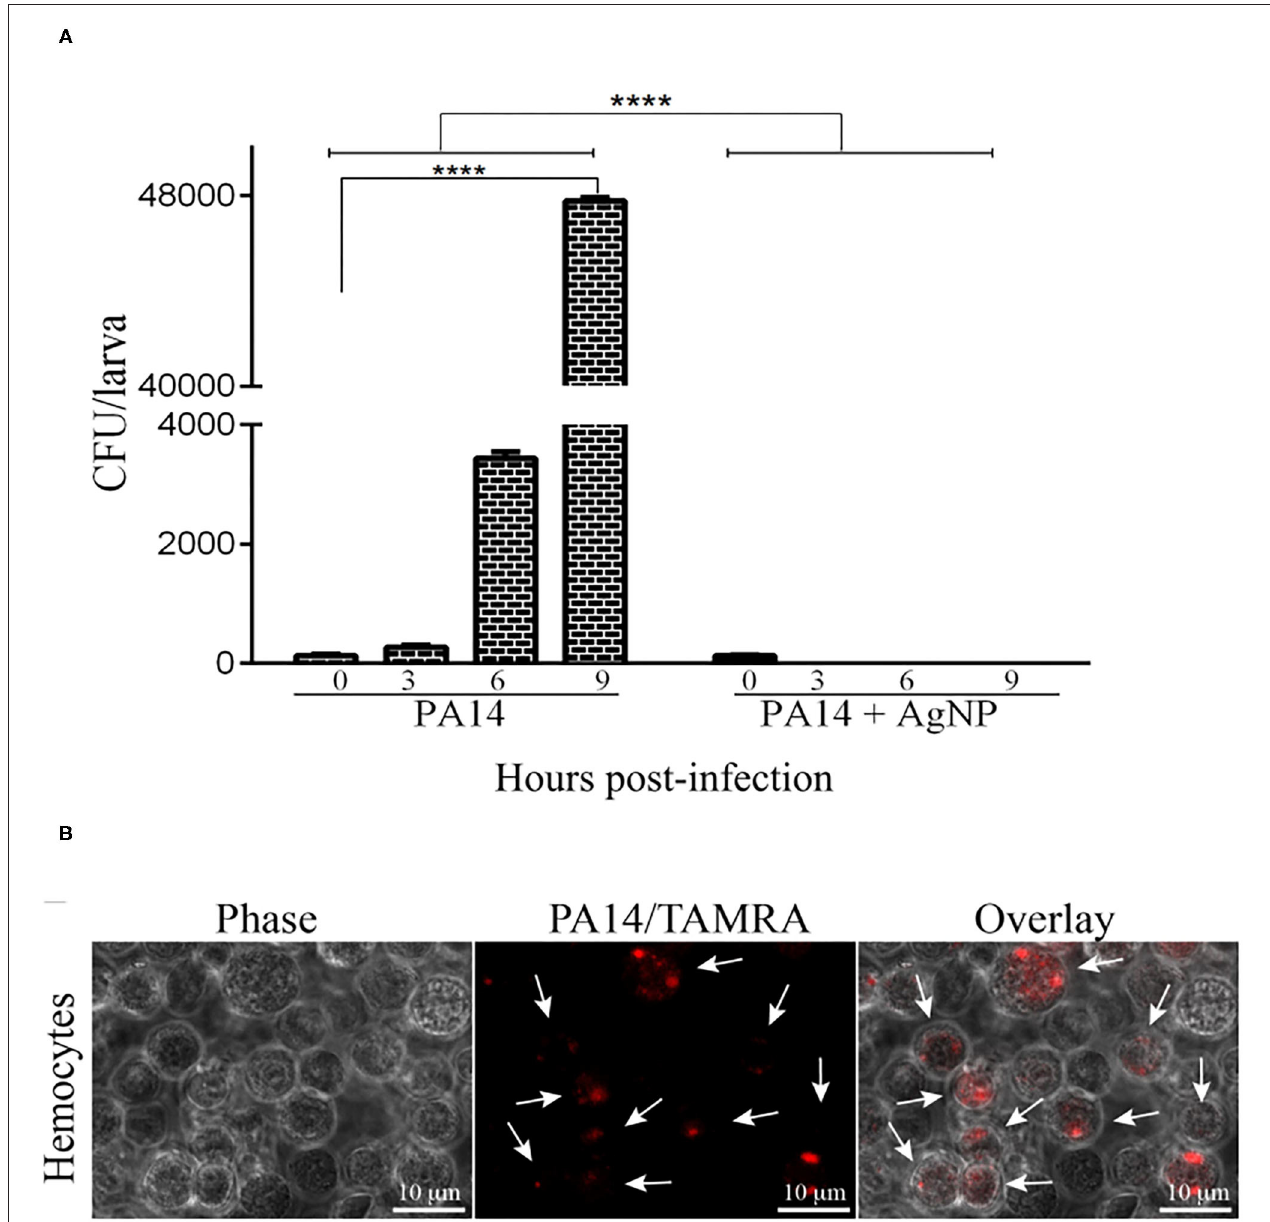
FIGURE 4 | Bacterial growth in the haemolymph of infected larvae . (A) 16 larvae were pre-treated with AgNPs and inoculated with P. aeruginosa . Zero, three, six, and nine hours following infection, the larvae haemolymph was extracted and plated on L-agar plates containing 25 µ g/ml nalidixic acid. Following a 24 h incubation at 37 ℃ the CFU on the plates were counted. Each bar represents the mean of three independent experiments. **** p < 0.0001 (ANOVA and RM ANOVA followed by t -test). (B) Microscopic images of hemocytes from G. mellonella internalized with PA14. Bacteria cells were stained with TAMRA. Scale bars 10 µ m. White arrowheads point to bacteria inside the hemocytes. Photos are representative of three independent